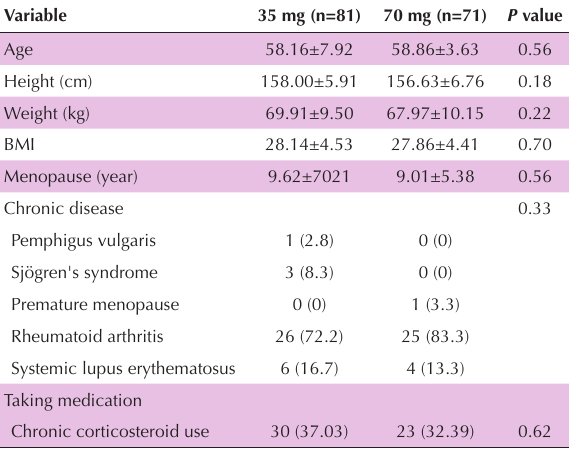
Table 1. Comparison of demographic variables in two groups with doses of 35 and 70 mg of alendronate